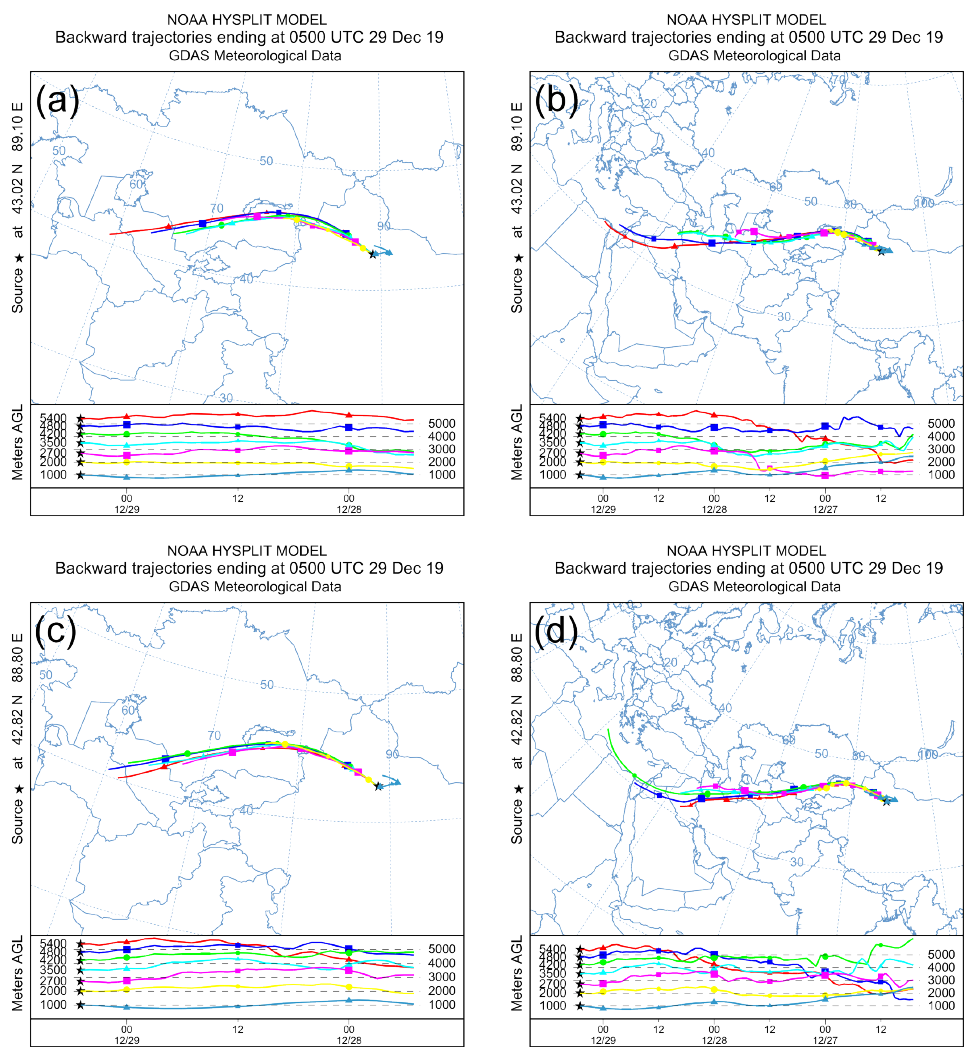
Figure 8. HYSPLIT backward trajectories at different altitudes of 36 h ( a ), 72 h ( b ) during the ascent stage, and 36 h ( c ), 72 h ( d ) during the descent